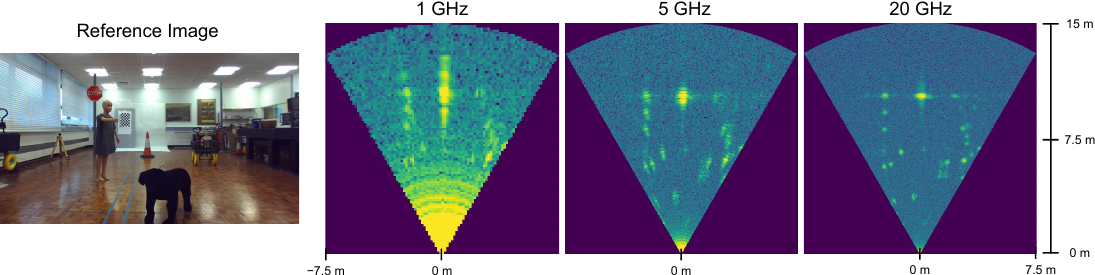
Figure 2. Images from the 300 GHz radar with different radar bandwidths. The data were collected at the University of Birmingham using the system described in [13].